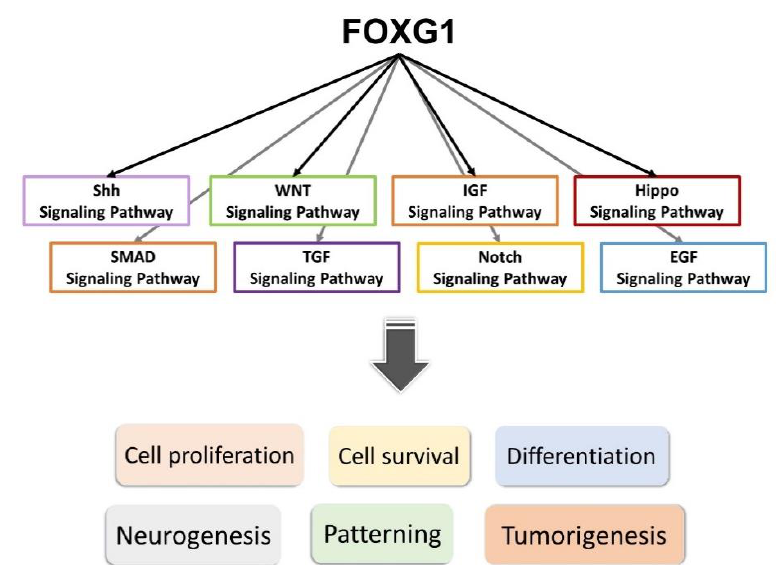
Figure 3. FOXG1 interacts with members of different signaling pathways — including the Shh, WNT, IGF, Hippo, SMAD, TGF, Notch, and EGF signaling pathways — that are important in neurodevelopment, and promotes proliferation, survival, and differentiation of neurons or other cell types. It exerts critical impacts on neurogenesis and patterning of the telencephalon, and may also be associated with tumorigenesis.